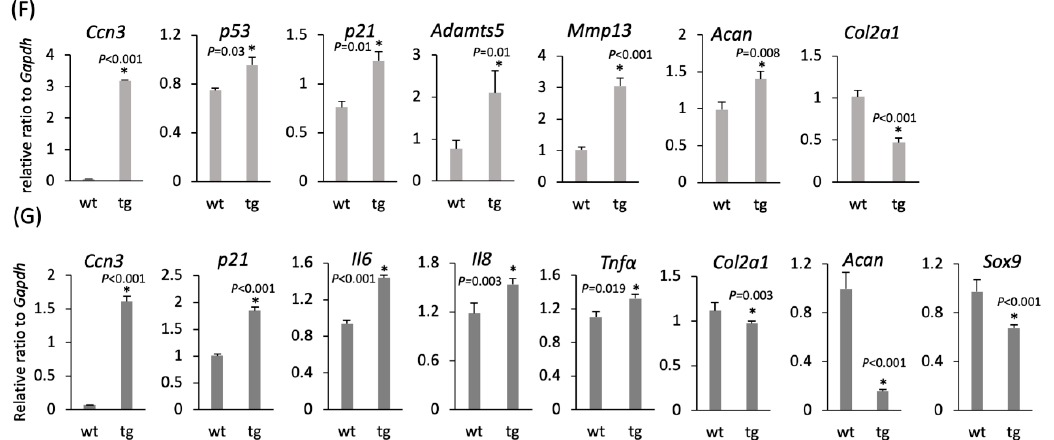
Figure 5. Degradative changes in knee joints and rib chondrocytes as a result of cartilage specific CCN3 overexpression in mice. ( A ) Whole mount LacZ staining of transgenic knee joints harboring a Col2a1 promoter-GFP-CCN3-LacZ construct (medial view). Beta-galactosidase activity was traceable up to 18 months after birth. ( B ) Histological analysis of ( A ) and counterstained with eosin. ( C , D ) Safranin-O staining of two-month-old ( C ) and seven-month-old ( D ) Ccn3 tg mice. ( E ) Immunohistochemical staining of Aggrecan Neoepitope in two-month-old Ccn3 tg mice knee articular cartilage. (wt -1st Ab) Negative control without 1st antibody of wt sections. ( F , G ) Analysis of gene expression of extracellular matrices and matrix metalloproteinases in chondrocyte RNA obtained from ( F ) rib cage chondrocytes of embryonic 18.5-day-old and ( G ) ribcages of three-month-old of tg mice. ( F ) Increased expression of p53, p21 and decreased expression Col2a1 mRNAs, were observed. ( G ) High expression levels of p21 and decreased expression levels of Col2a1 , Acan , and Sox9 were observed. Furthermore, the expression levels of inflammatory factors Il6 , Il8 , and Tnf α were increased. The p53 expression did not show significant differences (data not shown). Scale bar: 200 µm.